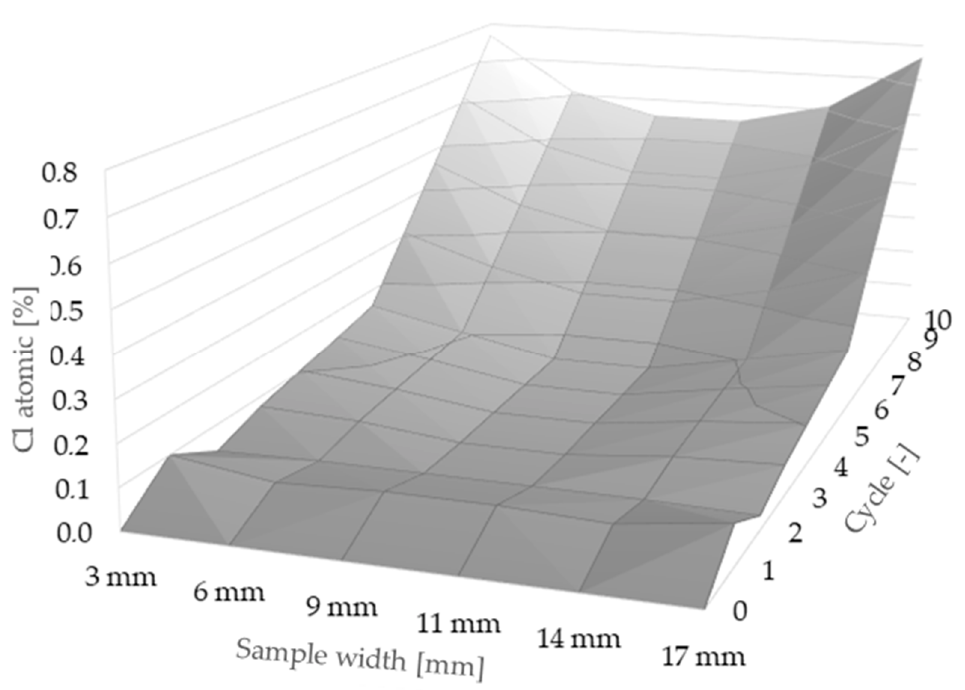
Figure 2. Elementary distribution of chlorine content (atomic%) within the cross-section of the specimens for cycle 1, 2, 3, 6, and 10 of n = 2 samples each spot. For cycles 4, 5, 7, 8, and 9 the values were interpolated.